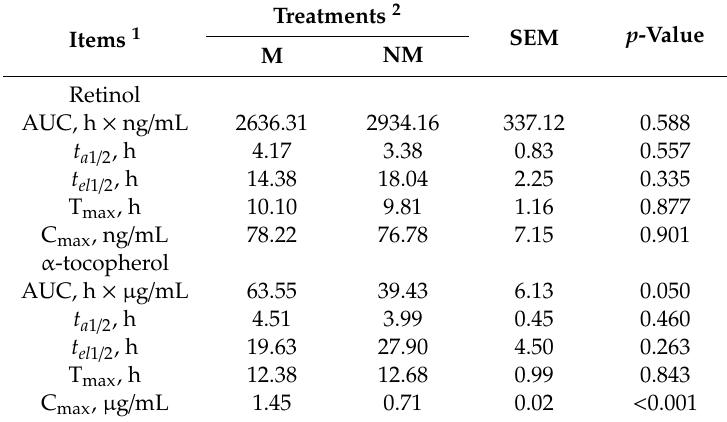
Figure 1. Values are the means ± SEM. ( a ) The plasma concentration–time profile of retinol concentrations for pigs. The M means oral microencapsulated vitamin A as retinyl acetate, and the NM means oral non-microencapsulated vitamin A as retinyl acetate; ( b ) The plasma concentration–time profile of α -tocopherol concentrations for pigs. The M means oral microencapsulated vitamin E as D, L- α -tocopherol acetate, and the NM means oral non-microencapsulated vitamin E as D, L- α -tocopherol acetate. Table 4. Pharmacokinetics of plasma retinol and α -tocopherol concentrations for nursery pigs.